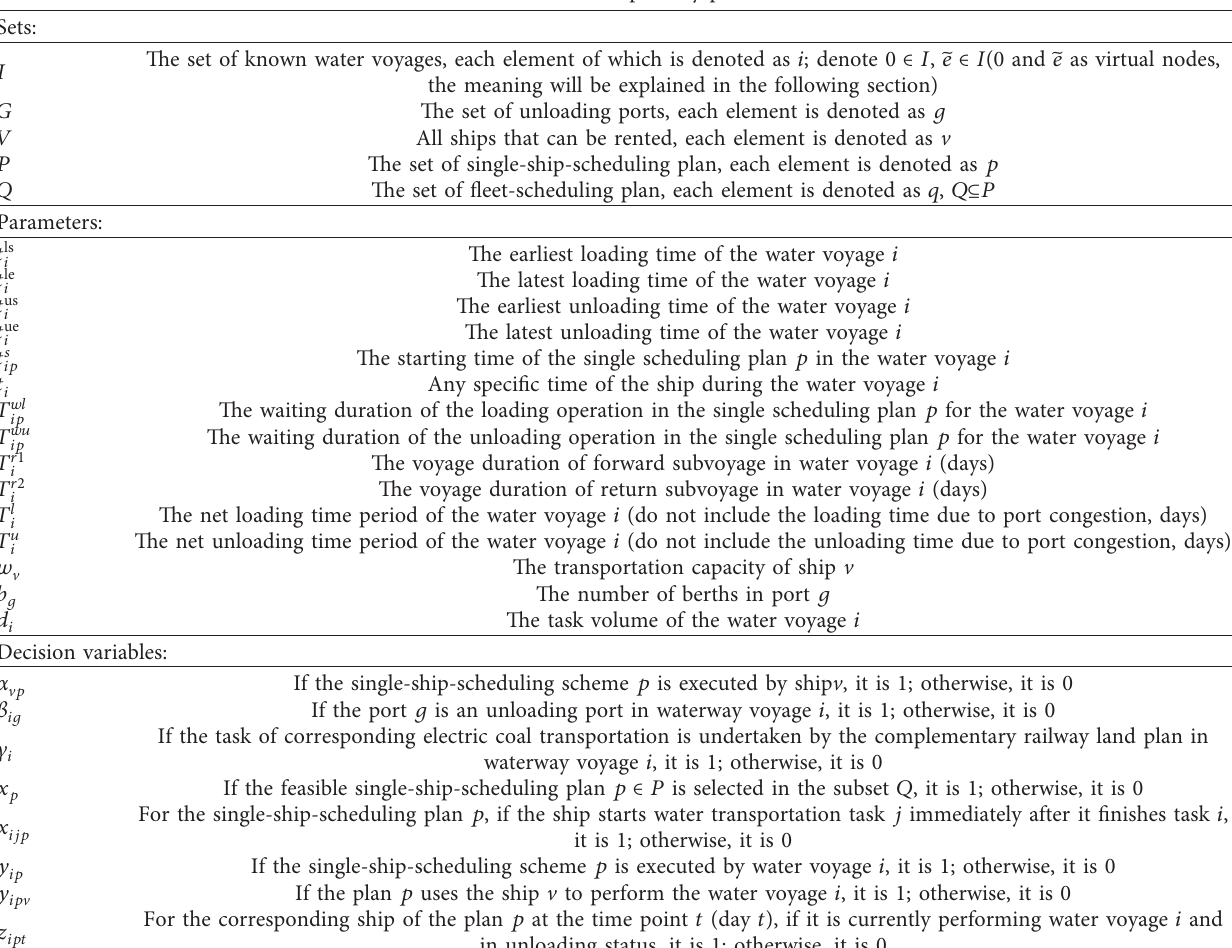
Table 1: Notation and primary